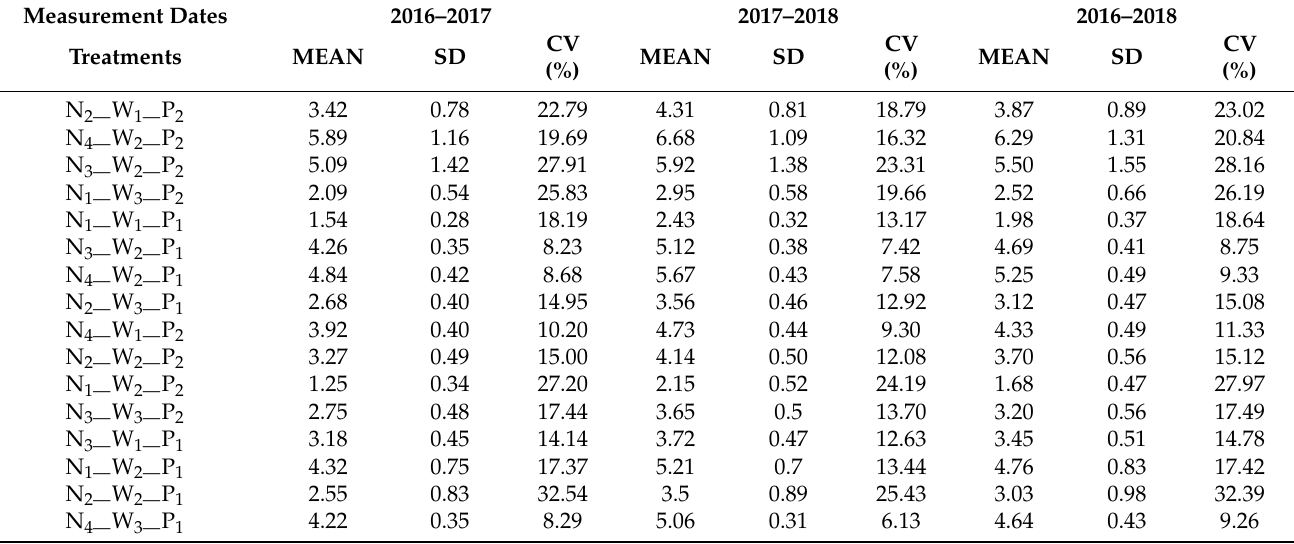
Table A5. Main statistical parameters of LAI at the anthesis stage under different